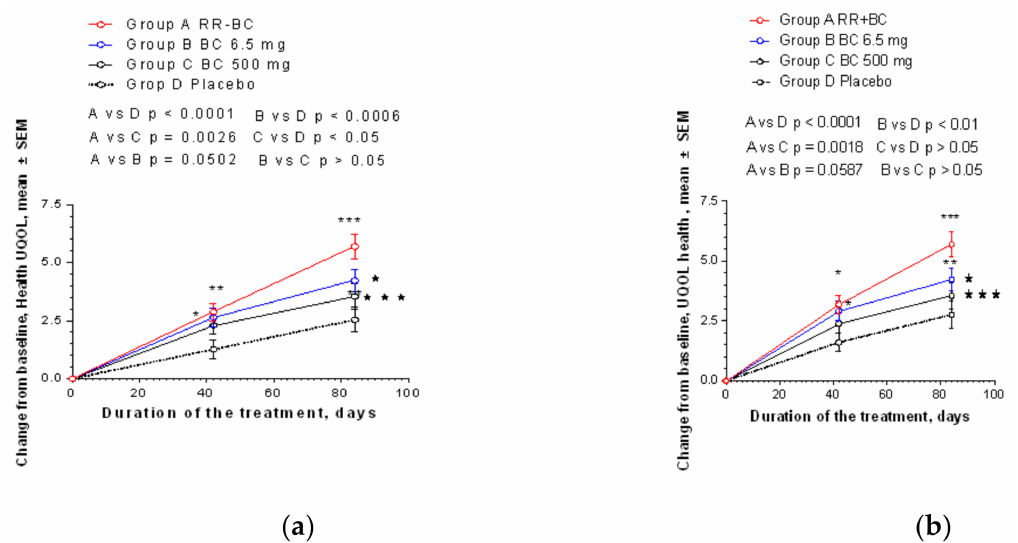
Figure A4. The change from baseline of menopause UQOL physical health domain scores (mean ± SD) over time: ( a ) -ITT analysis, ( b ) -PP analysis. Significance of di ff erence between groups at various time points, calculated by Bonferroni post-test, is expressed by symbols * p < 0.05, ** p < 0.01, *** p < 0.001; ns: not significant (A, B, C vs. placebo) and * p < 0.05 (C vs. A), *** p < 0.001 (B vs.